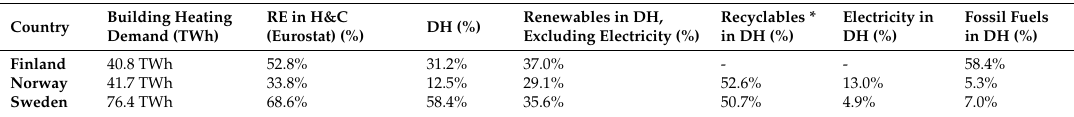
Table 4. Building heating demand (TWh), %—shares of renewable energy (RE) in heating and cooling (H&C) [13,14]. %—shares of DH and energy resources in DH in 2015 [16,20–23]. Country Building Heating Demand (TWh) RE in H&C (Eurostat) (%) DH (%) Renewables in DH, Excluding Electricity (%) Recyclables * in DH (%) Electricity in DH (%) Fossil Fuels in DH (%) Finland 40.8 TWh 52.8% 31.2% 37.0% - - 58.4% Norway 41.7 TWh 33.8% 12.5% 29.1% 52.6% 13.0% 76.4 TWh 68.6% 58.4% 35.6% 50.7% 4.9%